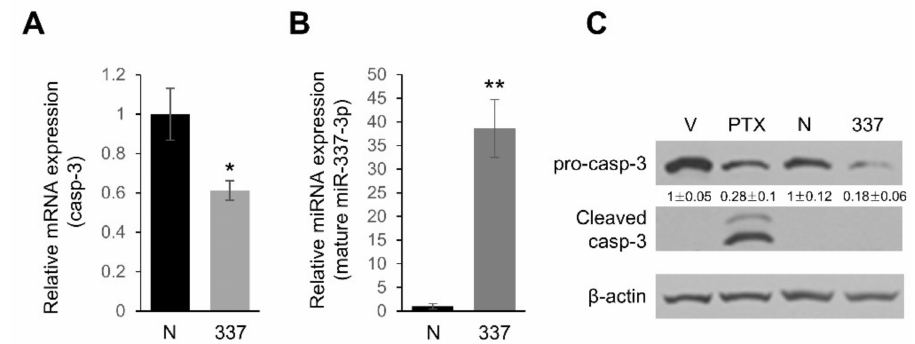
Figure 5. Caspase-3 (casp-3) is downregulated in miR-337-3p overexpressing cells. ( A ) The level of casp-3 mRNA was determined by real time qPCR and normalized with the 18S RNA level in PANC-1 cells after transfection of pre-miR-negative control (N) or pre-miR-337-3p (337). * p < 0.01. ( B ) Treatment conditions were the same as in ( A ) and the expression level of mature miR-337-3p in PANC-1 cells was determined by real time qPCR. ** p < 0.001. ( C ) Either pre-miR-nega control (N) or pre-miR-337-3p (337) was transfected into PANC-1 cells at 50 nM for 48 h, and then protein lysates were subjected to Western blot analysis of pro-casp-3 and cleaved casp-3. Paclitaxel (PTX) treated (1000 nM for 48 h) PANC-1 cells were used as a positive control of cleaved casp-3 expression. β -actin served as a loading control and relative expression are indicated. V indicates vehicle (DMSO) treated cells. Western blotting and qPCR were performed on separately treated samples of